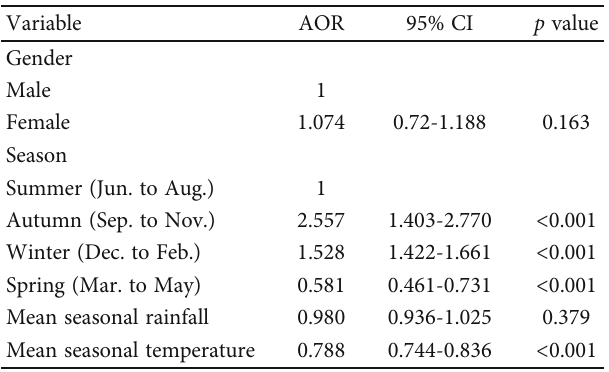
with P. falciparum and P. vivax infection during